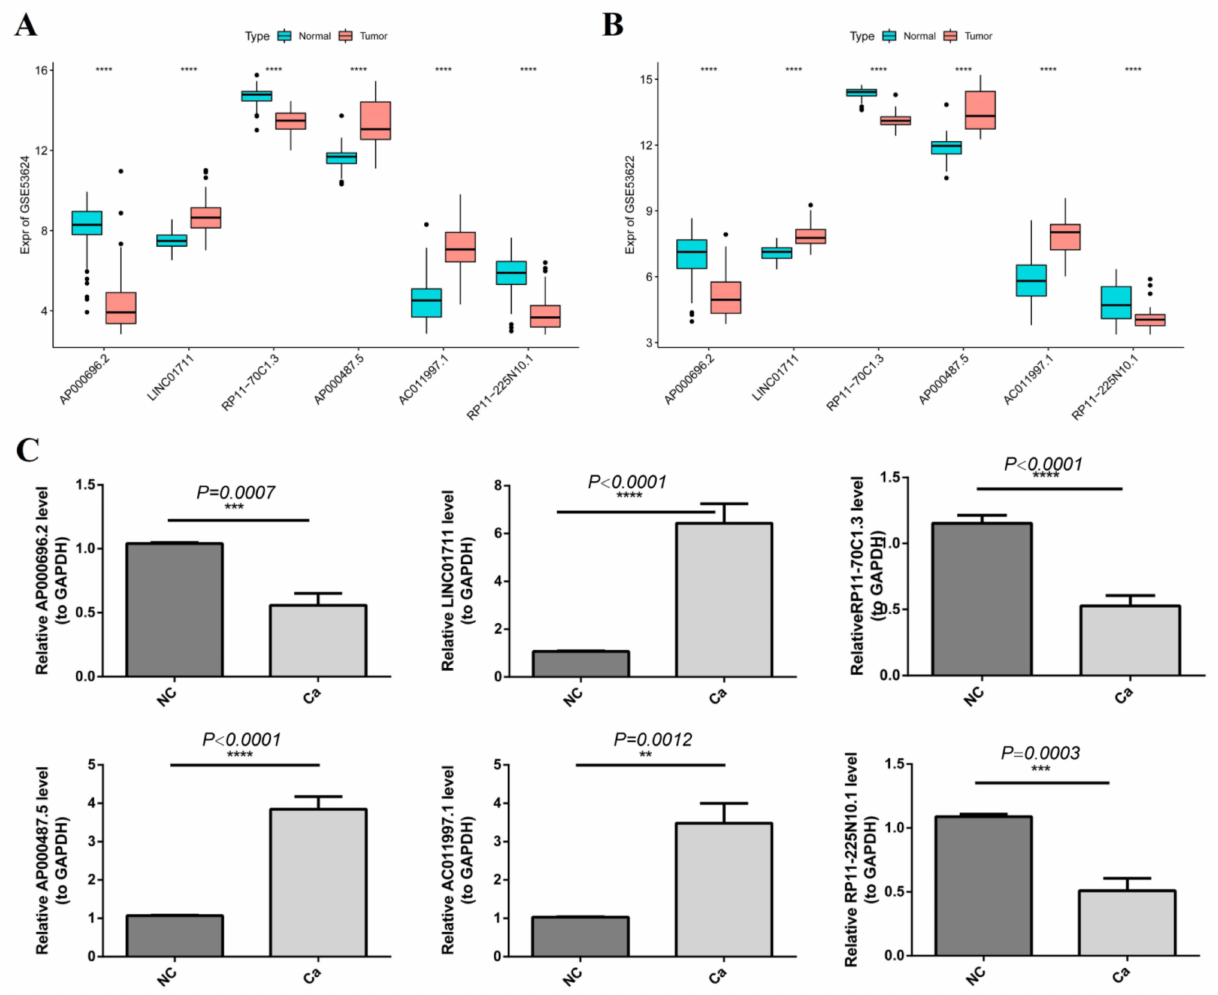
Figure 10. The expression of the six-DEARlncRNA was verifed by qRT-PCR. ( A , B ) The mRNA expression levels of the six-DEARlncRNA signature in 179 cancer samples and corresponding adjacent samples from the GSE53624 (( A ), n = 119) and GSE53622 dataset (( B ), n = 60). Black dots indicated discrete samples. ( C ) Expression of six-DEARlncRNA in 10 pairs of ESCC and adjacent normal tissues by qRT-PCR. ** p < 0.01; *** p < 0.001; **** p <